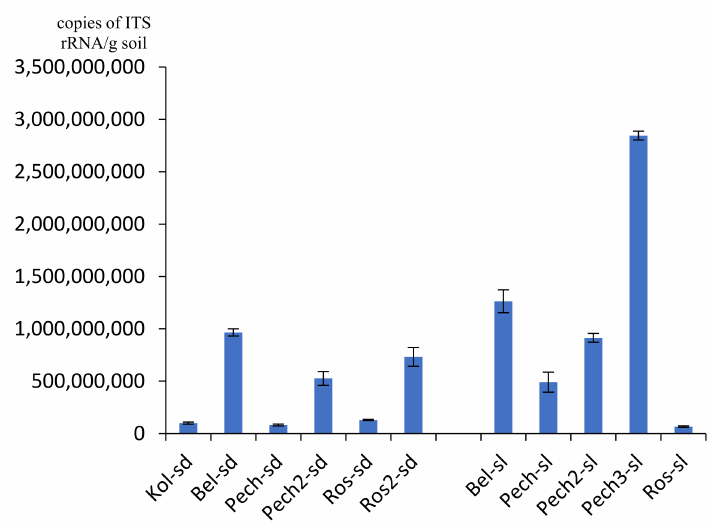
Figure 3. Number of ITS rRNA gene copies of